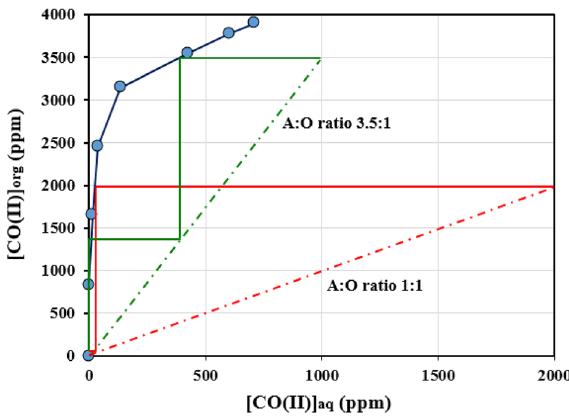
Figure 7. Cobalt extraction distribution isotherm and McCabe–Thiele diagram under optimum condition (80% EG (+ 0.1 M LiCl); 0.05 M Cyanex301; T = 25 °C; time = 10 min; Co(II) = 800 ppm; pH =